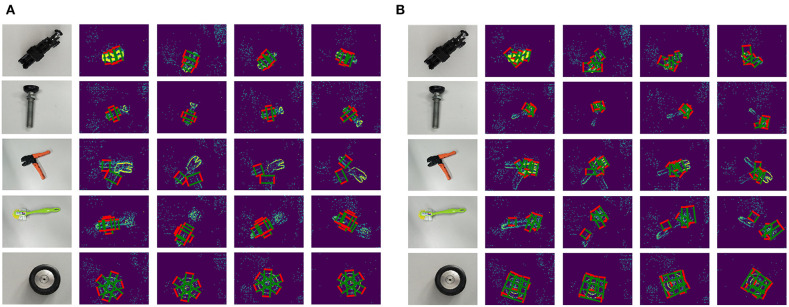
Multi-grasping Annotations: (A) Good grasping parallelogram annotations on original objects' event data; (B) Bad grasping parallelogram annotations on original objects' event data. There are five typical objects selected, and there are four sampled time points in each recorded moving period. The first column presents the real grasping objects in traditional RGB image; the rest of the columns present the annotations and original objects' event data. The red edges present the grasping edge, and the green edges present the auxiliary edges.